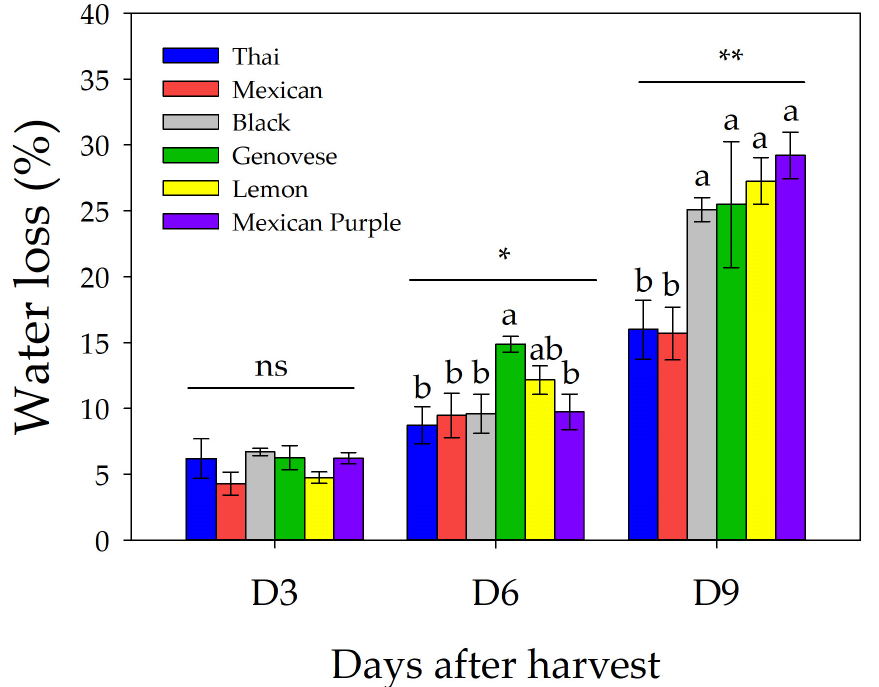
Figure 2. Comparison of Thai, Mexican, Black, Genovese, Lemon, and Mexican Purple basil on water loss percentage measured after three (D3), six (D6) and nine (D9) days after 10 ◦ C storage. Data are mean values ± standard error, n = 5. Mean comparisons were performed by Tukey HSD test within each time point. Different letters indicate significant mean differences. Asterisks denote significant effects according to ANOVA within each date (ns = nonsignificant; * = p ≤ 0.05; ** = p ≤ 0.01). As shown in Table 2, statistical analysis indicated significant differences for E, A CO2 , and WUEi. The lowest A CO2 and WUEi were recorded in Mexican Purple. As for E, the values recorded in Mexican were about 1.2 times higher than those in Genovese. Table 2. Comparison of Thai, Mexican, Black, Genovese, Lemon, and Mexican Purple basil on transpiration (E), stomatal conductance (gs), net CO 2 assimilation rate (A CO2 ), and instantaneous water use efficiency (WUEi).